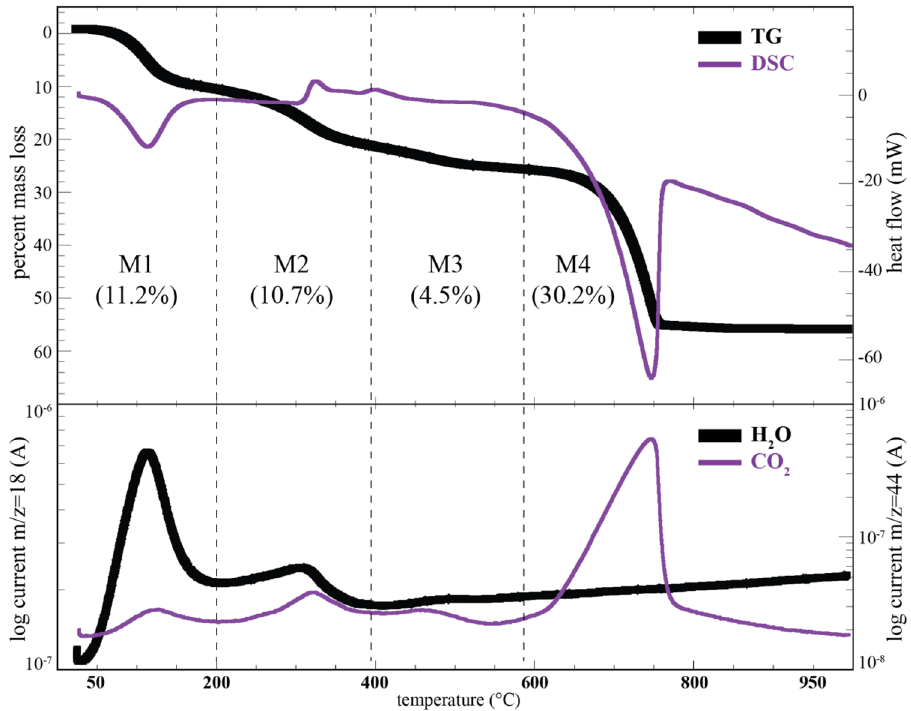
Figure 5. Thermal (TG and DSC) and EGA data for the FSY HACC. M1 to M4 refer to the four distinct mass- loss ranges discussed in the text, and the corresponding percent mass loss within each range in parentheses. The EGA data (bottom panel) show the ion curves for m/z = 18 (H 2 O + ) and m/z = 44 ( 12 CO 2 + ) on a log intensity